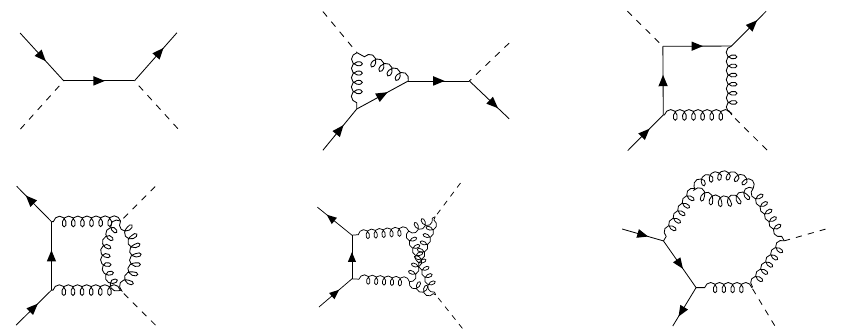
Figure 3. Sample diagrams for q ¯ q → ˜ φ ˜ φ at NNLO ( O ( a 4 category. The remaining two diagrams in the first row belong to O G O J . The diagrams in the second row fall under O G O G